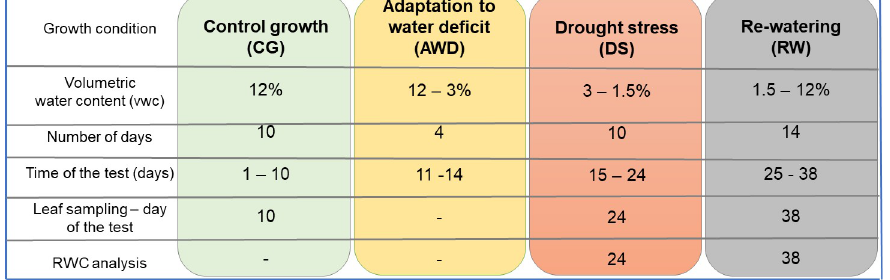
Fig 1. Drought stress treatment during seedling stage for the ‘Sebastian’ variety. The plant material was collected for RNA isolation after: (1) 10 days of growth under optimal water condition, soil moisture 12% vwc– c ontrol g rowth (CG); (2) 14 days of drought stress including 4 days of a daptation to w ater d eficit (AWD), soil moisture gradual decrease from 12% to 3% and 10 days of d rought s tress (DS), soil moisture 3% to 1.5%; (3) after 14 days of r e- w atering (RW), soil moisture gradual increased from 1.5% to 12%. The RWC analysis was performed on 10 d ays a fter s owing (DAS) under control growth (CG), 25 DAS under drought stress and on 38 DAS under re-watering.